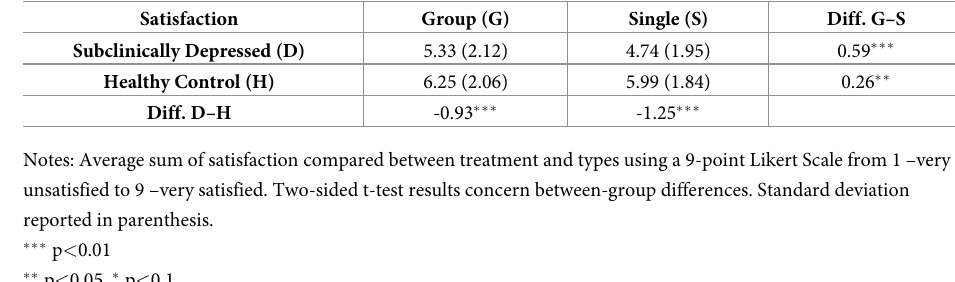
Table 8. Individual satisfaction by